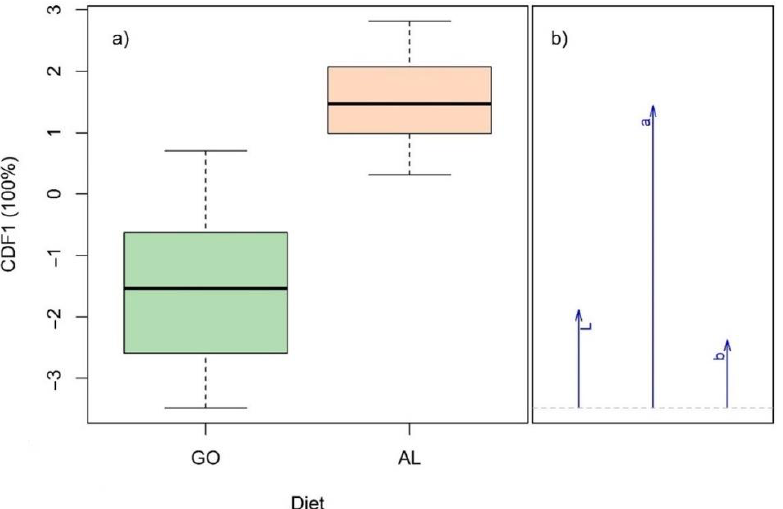
Figure 1. Canonical score ( a ) and structure coefficient ( b ) plots for the 1st canonical discriminant function (CDF1) of the model build to discriminate G0 from AL samples using L*, a* and b* data recorded after 24 h of air exposure.